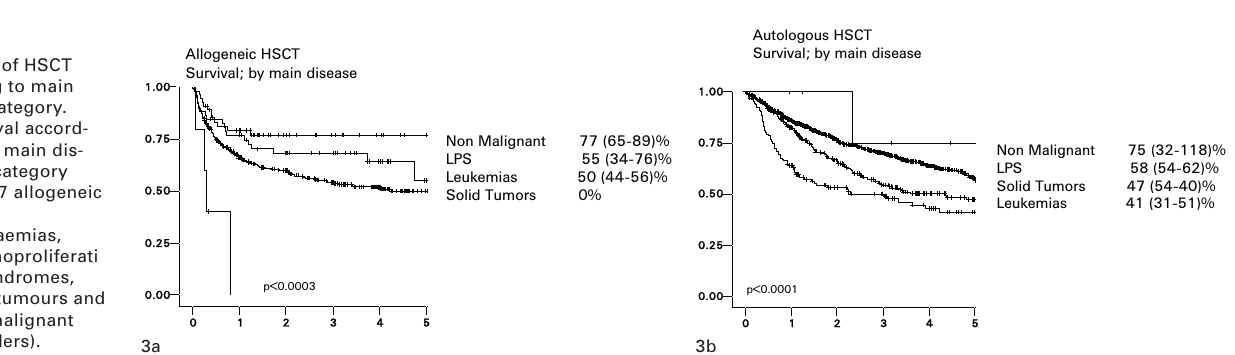
Figure 2 Influence of donor type in 577 allo- geneic HSCT. 2a: Survival of allo- geneic HSCT by donor type. HLA- identical sibling transplants, other family member transplants, unre- lated donor trans- plants and twin transplants. 2b: Relapse incidence of allogeneic HSCT by donor type. HLA-identi- cal sibling trans- plants, other fam- ily member trans- plants, unrelated donor transplants and twin trans- plants. 2c: Transplant related mortality of allo- geneic HSCT by donor type. HLA- identical sibling transplants, other family member transplants, unre- lated donor trans- plants and twin transplants.